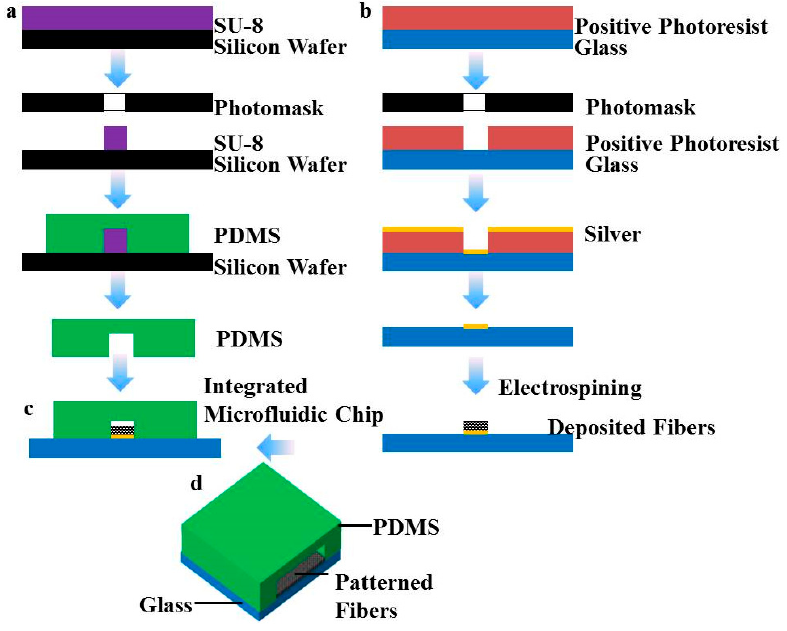
Figure 1. Schematic illustration of the microfabricated ( a ) patterned fibers and ( b ) microfluidic chips; ( c ) microfluidic chip integrated with patterned fibers; ( d ) 3D schematic illustration of a patterned fiber-embedded microfluidic chip.